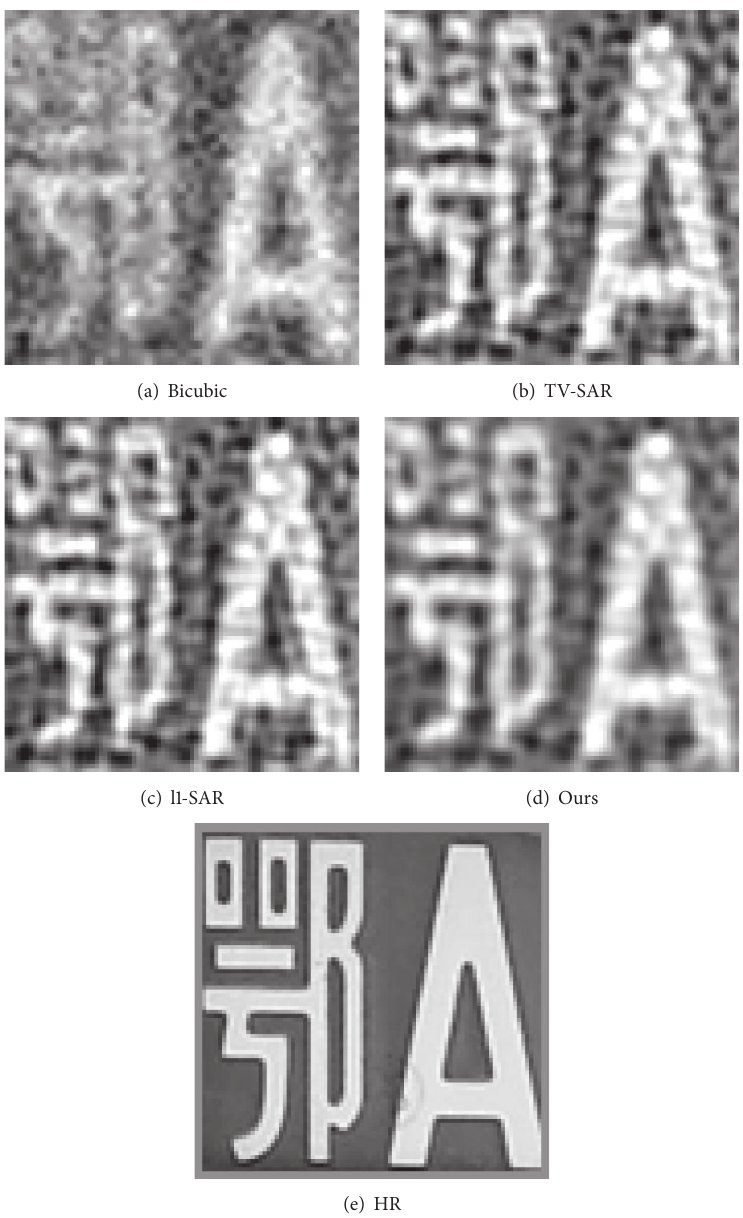
Figure 9: The reconstructed results for Figure 2(d) under white Gaussian noise with 𝜎 = 0.5